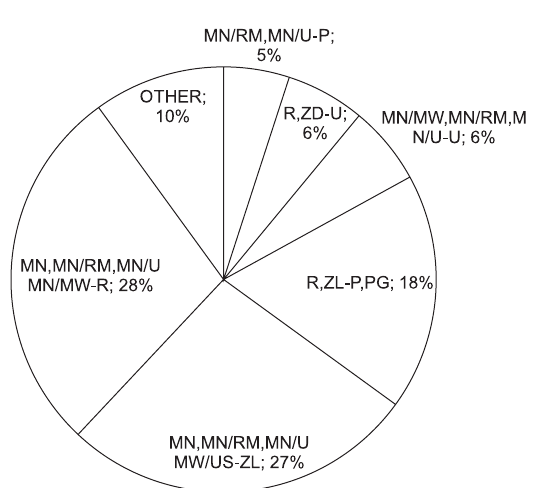
Fig. 3. Share of incompatibilities of land use allocations occurring on the border of the commune of Oleśnica – 2016. Source: own study based on field